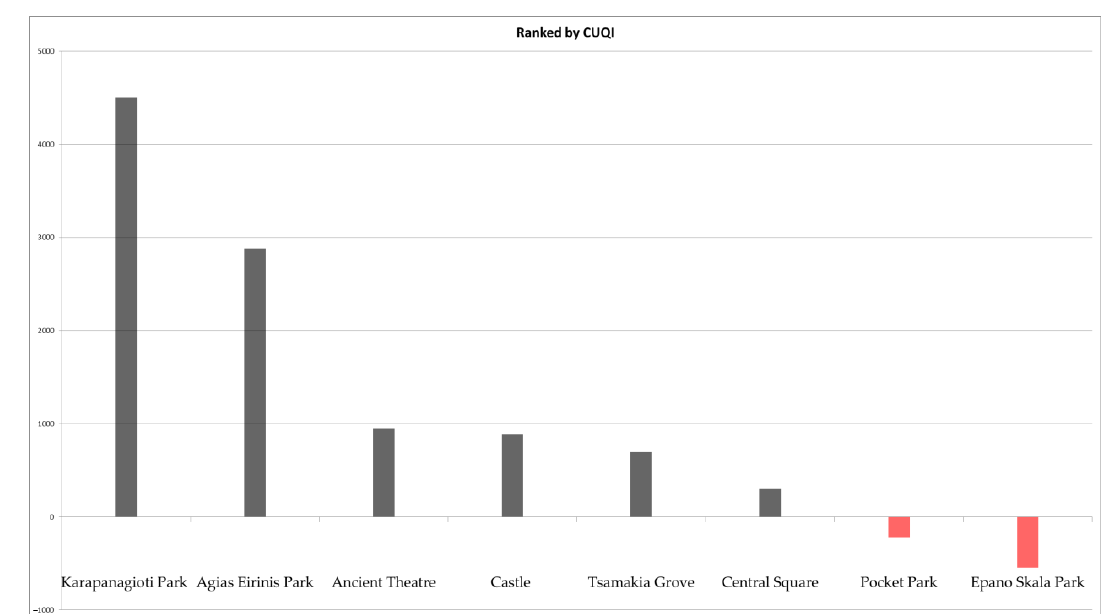
Figure 6. The potential quiet areas in order based on the results of the Analytical Hierarchy Process conducted (Matsinos et al., 2017).